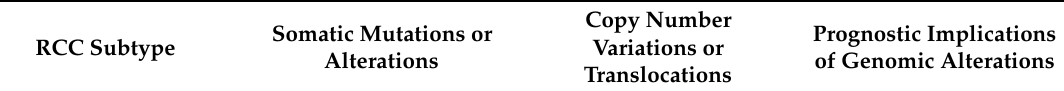
Table 2. Molecular abnormalities of main sporadic renal cell cancers